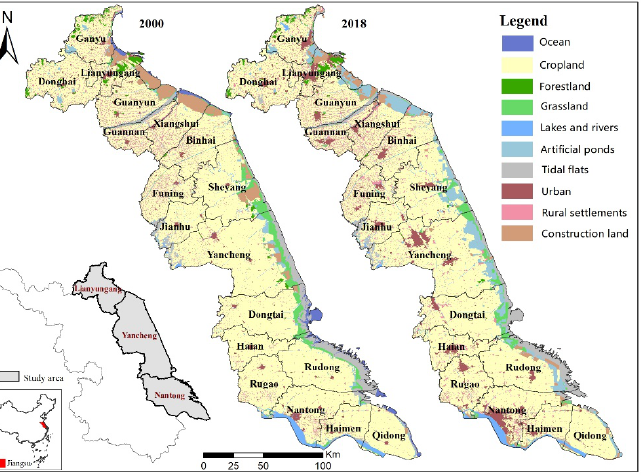
Figure 1. Location of the study area in Jiangsu coastal zone and the land-use category conversion from 2000 to 2018.